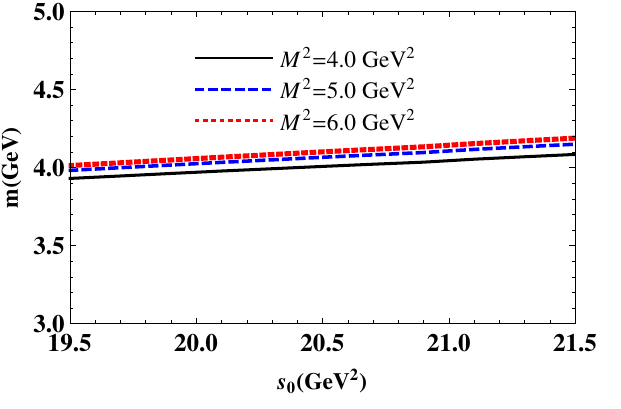
Figure 1 . The mass of the hadronic molecule M + s 0 . Vertical lines show boundaries of working region for M 2 used in numerical computations.